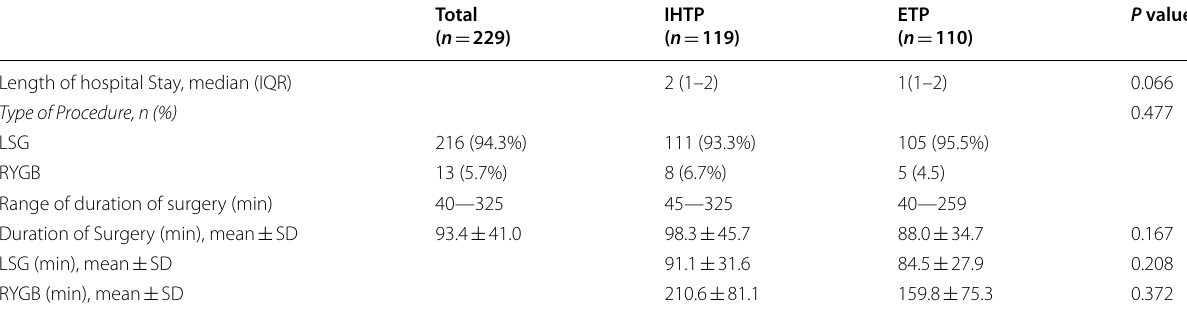
Table 2 Procedure characteristics in the two studied groups, N